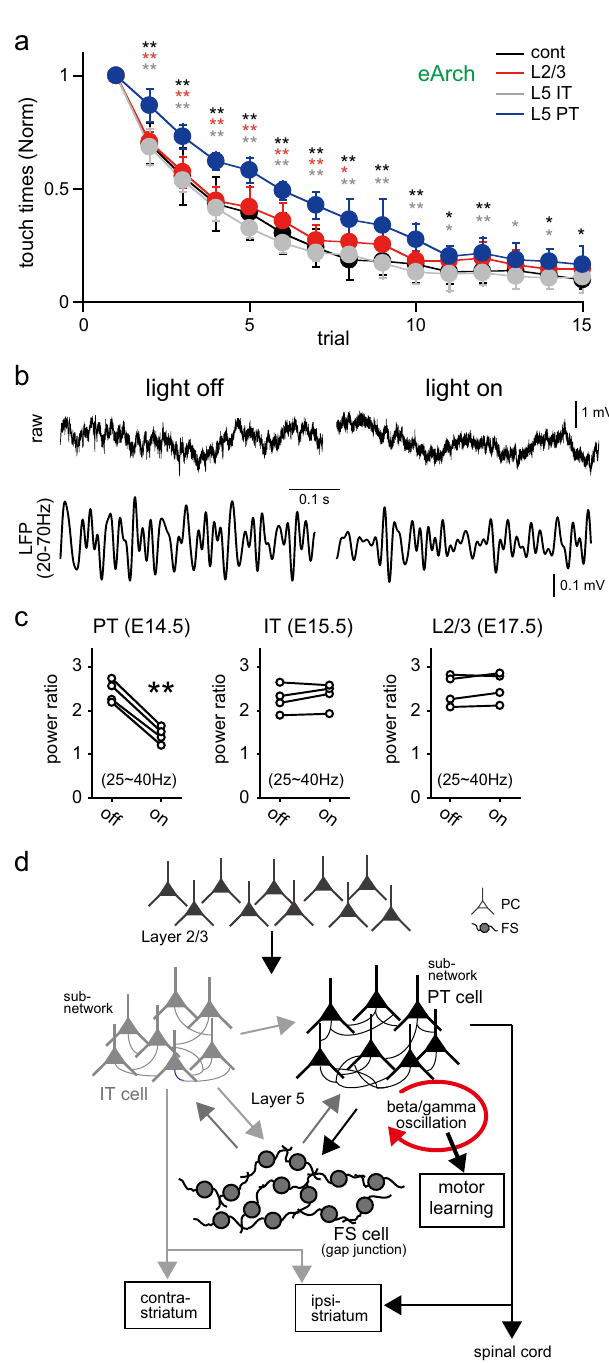
which are characterized by a facilitation property in response to repetitive spiking activity 4,7,8 . The requirements of these prop- erties were con fi rmed in silico by manipulation of relevant parameters in our computational model. During development, L5 cells cannot induce oscillation by optogenetic stimulations 40 , suggesting that maturation of network and cell properties is necessary to induce oscillatory activity. It has been proposed that recurrent connections between PCs and FS cells underlie the generation of oscillations in the cortex and hippocampus 25,41 . Consistent with this notion, our experi- mental and simulation studies suggest that recurrent connections between PT and FS cells generate oscillations in cortical circuits. Cortical PCs and FS cells frequently form reciprocal excitatory/